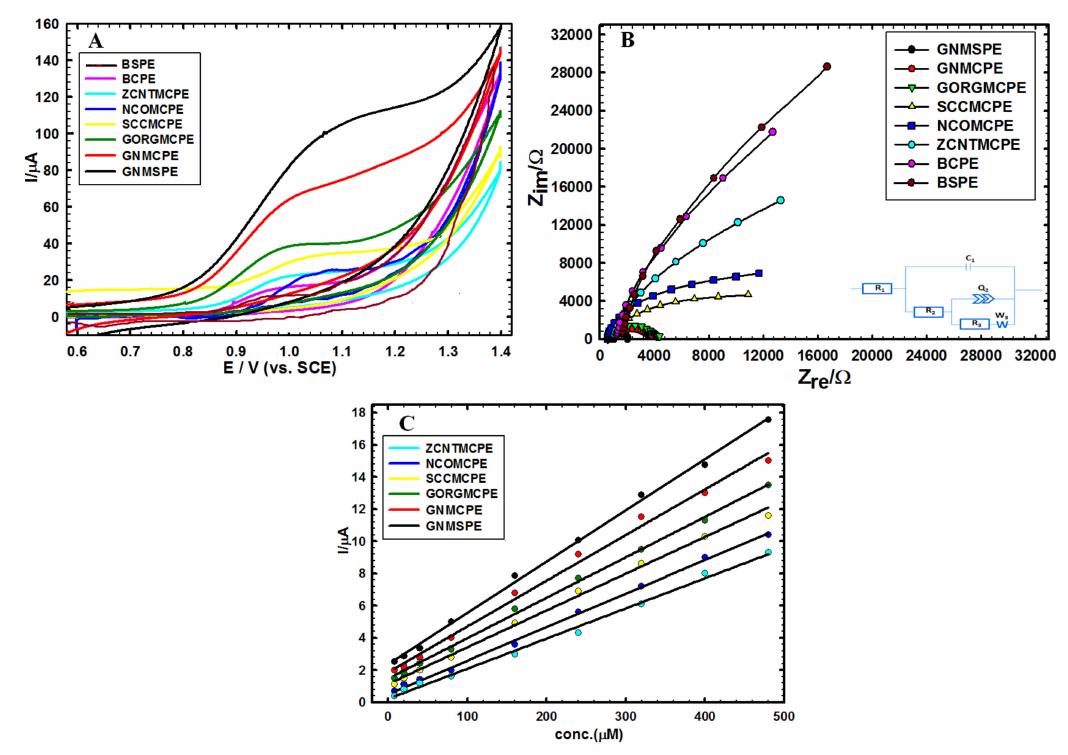
Figure A3. ( A ) CVs of 1.0 mM Moxi in 0.01 M B-R (pH = 7.0) and scan rate 50 mV s − 1 measured on Nyquist plots for the studied sensors (bottom right inset: the best fitted equivalent circuit). ( C ) The analytical curves obtained from performing DPV measurements at scan rate 10 mV s − 1 with sensing platforms ZCNTMCPE, NCOMCPE, SCCMCPE, GORGMCPE, GNMCPE and